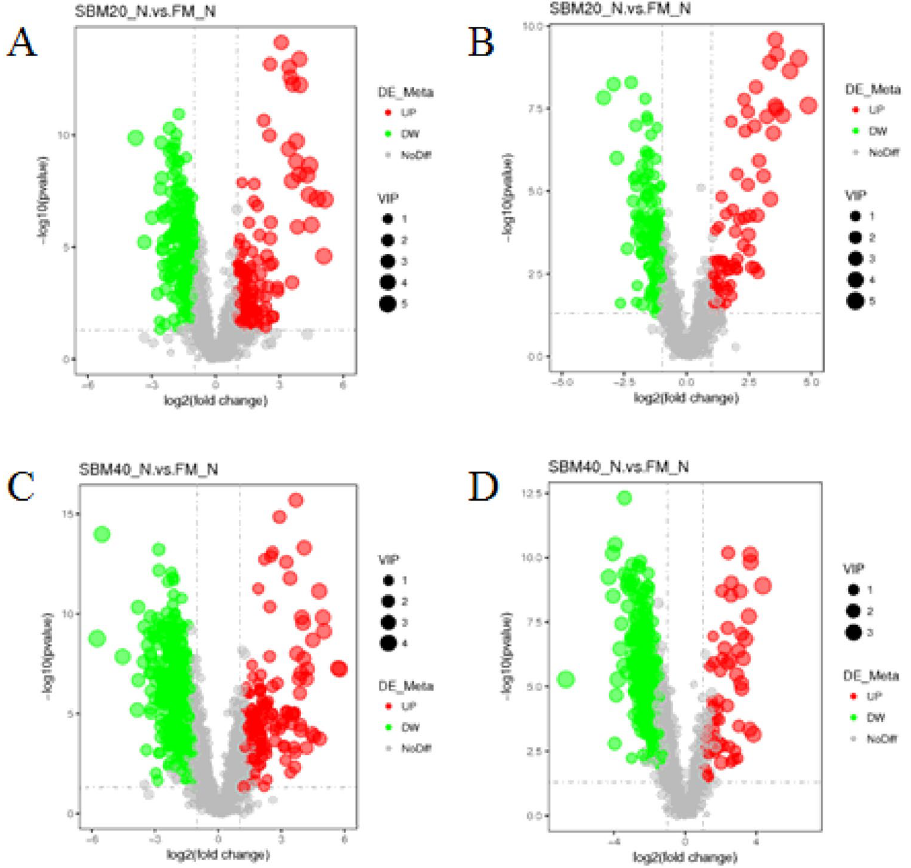
Figure 15. Volcano plot of P values between the FM, SBM20_N, and SBM40_N groups in positive ( A , C ) and negative ( B , D ) modes (n = 12). Note: Each dot represents a metabolite. Red dots represent significantly up-regulated metabolites, green dots represent significantly down-regulated metabolites, and gray dots represent metabolites with no significant difference. The point size represents the VIP value. FM_N, fish meal control group; SBM20_N, 20% SBM protein replacement level to FM protein; SBM40_N, 40% SBM protein replacement level to FM